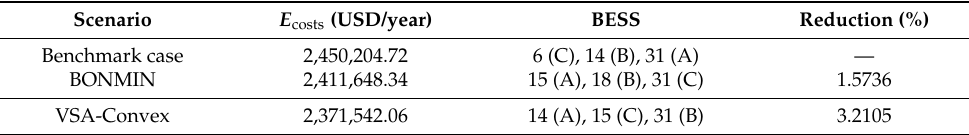
Table 5. BESS location reallocation when E costs is